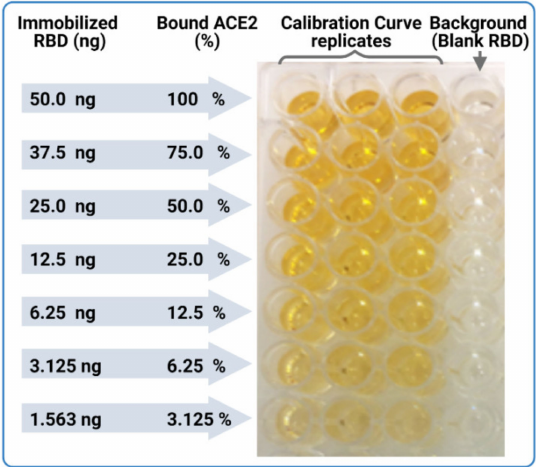
Figure 8. Sample of the calibration curve plate